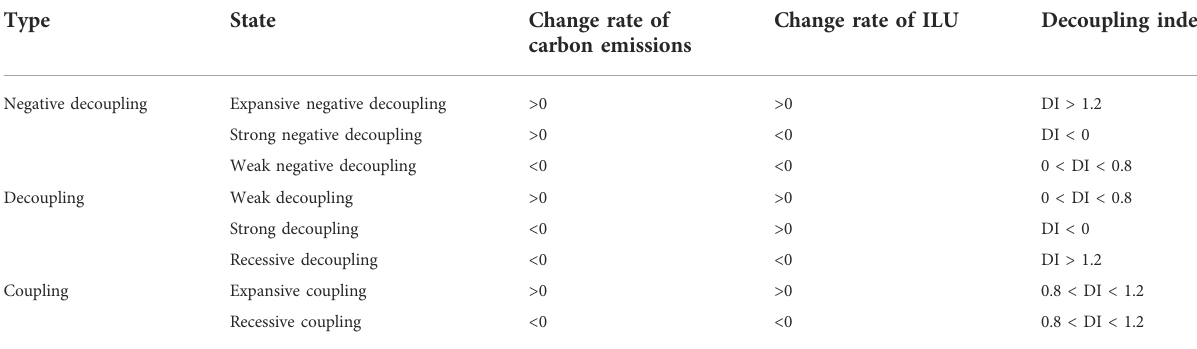
TABLE 4 Decoupling state division table.